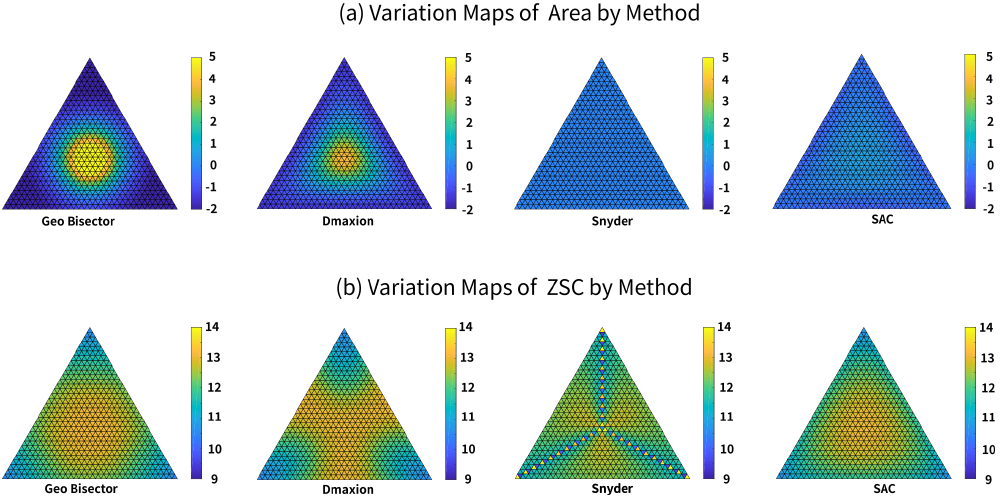
Figure 23. The distribution histograms of area and compactness for different methods. These values are for the icosahedron partitions.